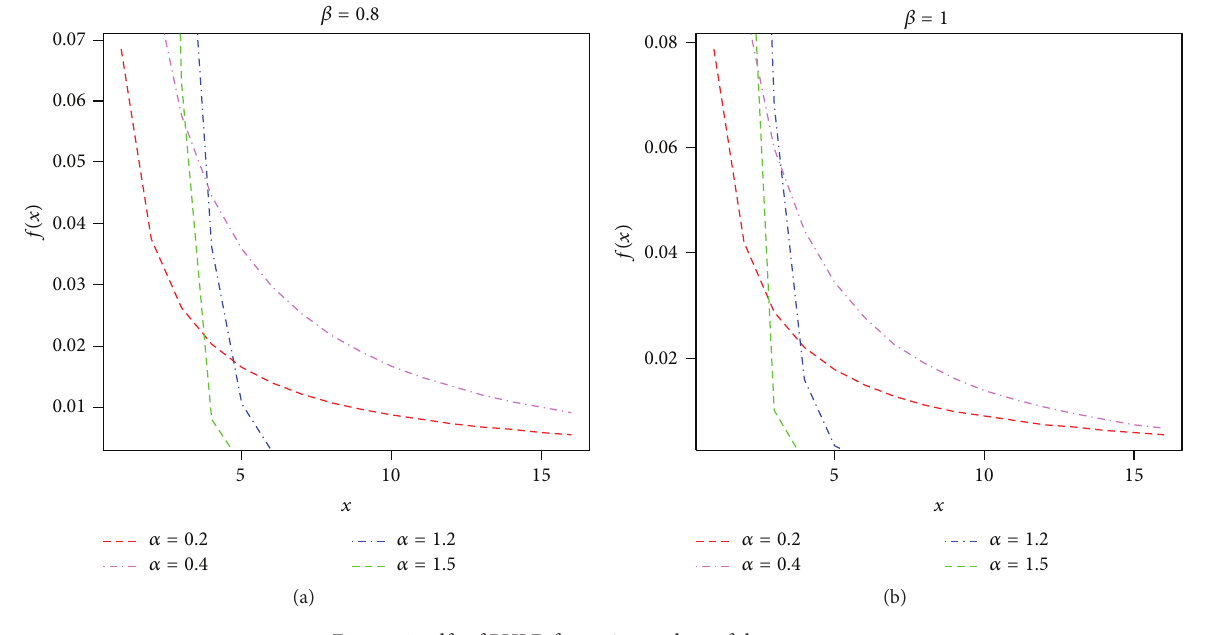
Figure 1: pdfs of PHLD for various values of the